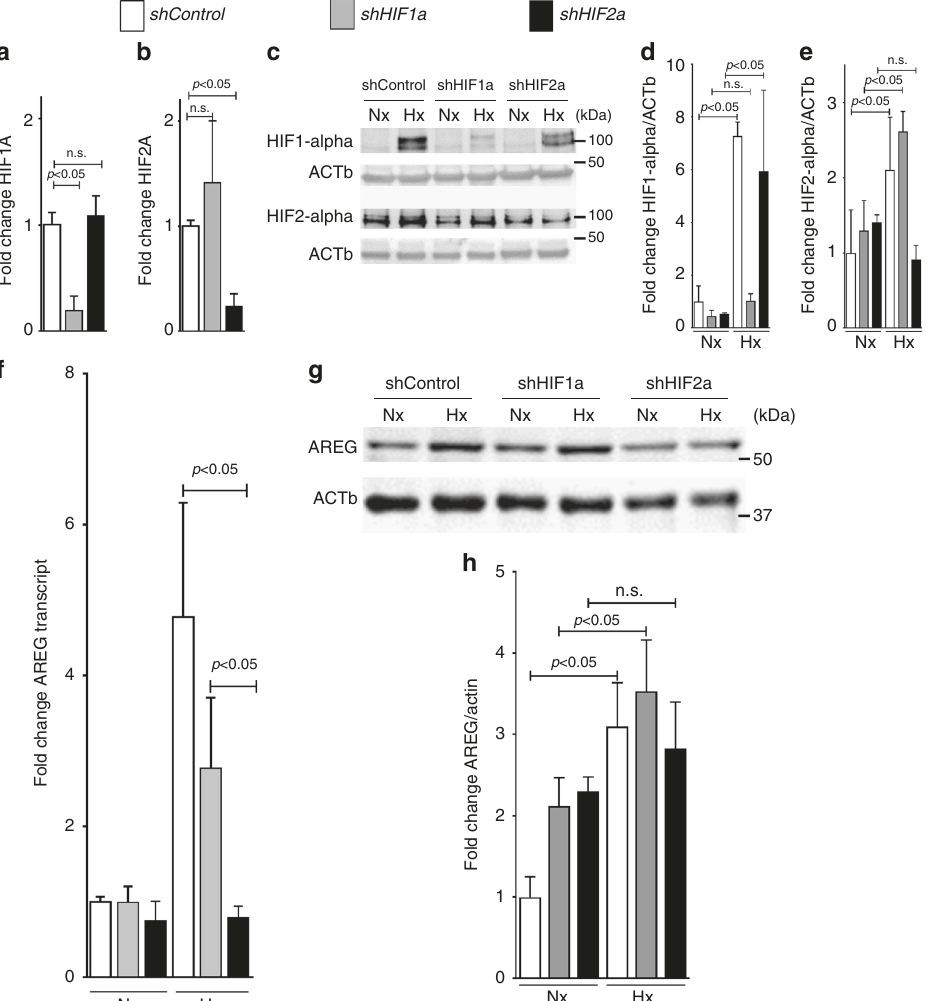
Fig. 3 Functional role of HIF2A in the transcriptional regulation of amphiregulin (AREG) in human cardiac myocytes. a – e Human cardiac myocytes (HCM) underwent control, HIF1A-speci fi c or HIF2a-speci fi c short hairpin RNA (shRNA) lentiviral transfection to suppress transcription of hypoxia-inducible factors HIF1A or HIF2A. a , b shRNA-transfected HCM were exposed to ambient hypoxia (1% oxygen) for 16 h and analysis of transcript changes by RT-PCR of HIF1A or HIF2A, respectively. Transcriptional changes were calculated relative to an internal housekeeping gene (Actin-b). Data are expressed as mean fold change ± SD compared to normoxic cells ( n = 6 per group). c Immunoblot for HIF1A or HIF2A from shRNA-transfected normoxic or hypoxic HCM. β - Actin (ACTb) served as a loading control. d , e Quanti fi cation by densitometry of the HIF1-alpha or HIF2-alpha immunoblot results relative to ACTb. Data are expressed as mean fold change ± SD normalized to shControl compared by one-way ANOVA followed by Bonferroni ’ s multiple comparison test ( n = 3 per group; d F 5,11 = 14.48, p = 0.0002; e F 5,11 = 6,726, p = 0.0042). f HCM transfected with shRNA directed against HIF1A , HIF2A or control shRNA were exposed to ambient hypoxia (1% oxygen) for 16 h or were maintained under normoxic conditions (21% oxygen). Subsequently, total RNA was isolated and probed by RT-PCR for transcriptional changes of amphiregulin ( AREG ). Data are expressed as mean fold change ± SD compared to normoxic cells ( n = 3 per group). Transcriptional changes were calculated relative to an internal housekeeping gene ( ACTb ). Data compared by one-way ANOVA followed by Bonferroni ’ s multiple comparison test (F 5,12 = 14.33; p = 0.0001 ). g HCM transfected with shRNA directed against HIF1A , HIF2A, or control shRNA, total protein was isolated and immunoblotted for AREG. b-Actin (Actb) served as a loading control. One representative blot out of three experiments is shown. h Quanti fi cation by densitometry of the HIF immunoblot results relative to ACTb. Data are expressed as mean fold change ± SD normalized to normoxic cells ( shControl) and compared by one-way ANOVA followed by Bonferroni ’ s multiple comparison test ( n = 3 per group; F 5,12 = 11, 58; p =